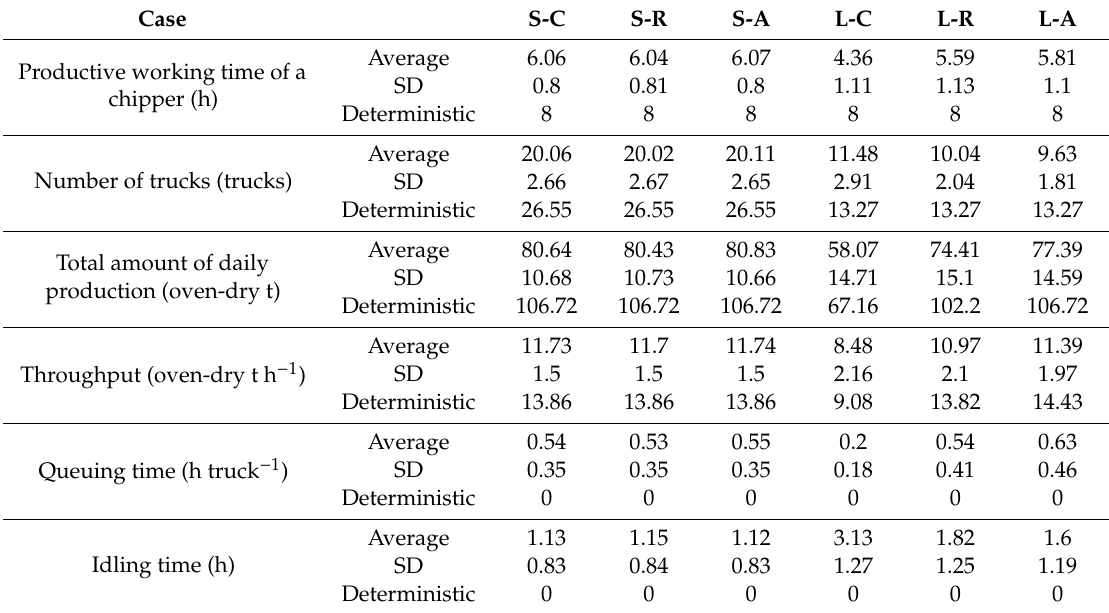
Table 4. Summary of the productive working time, number of trucks, the total amount of daily production, throughput, and the queuing and idling